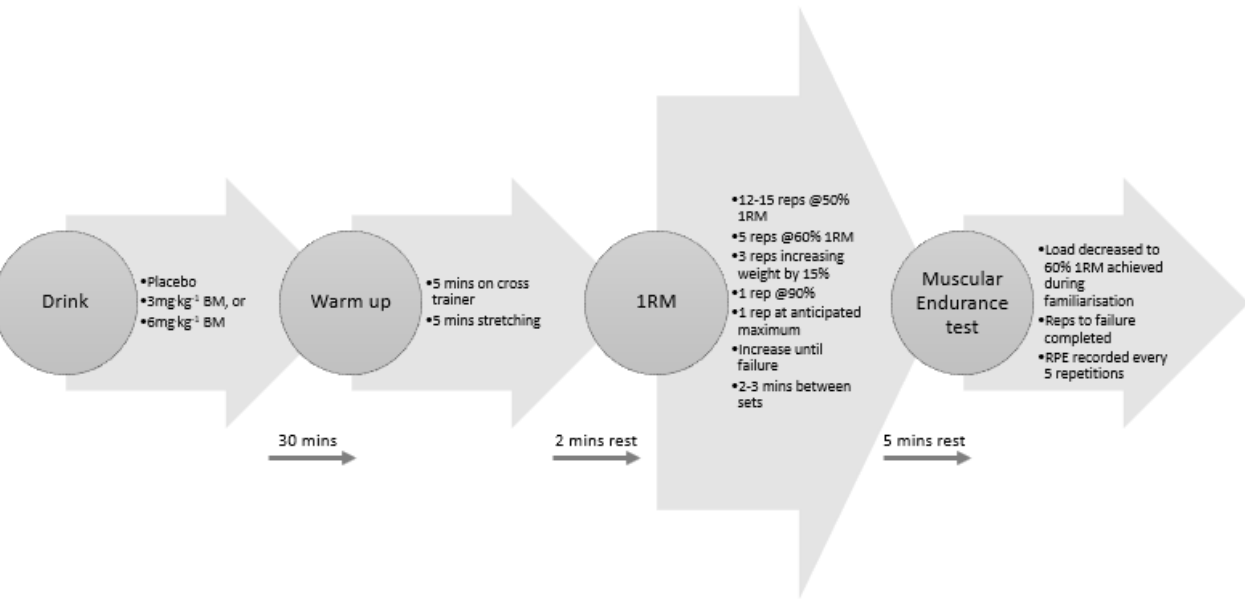
Figure 1. Schematic of the exercise protocol.